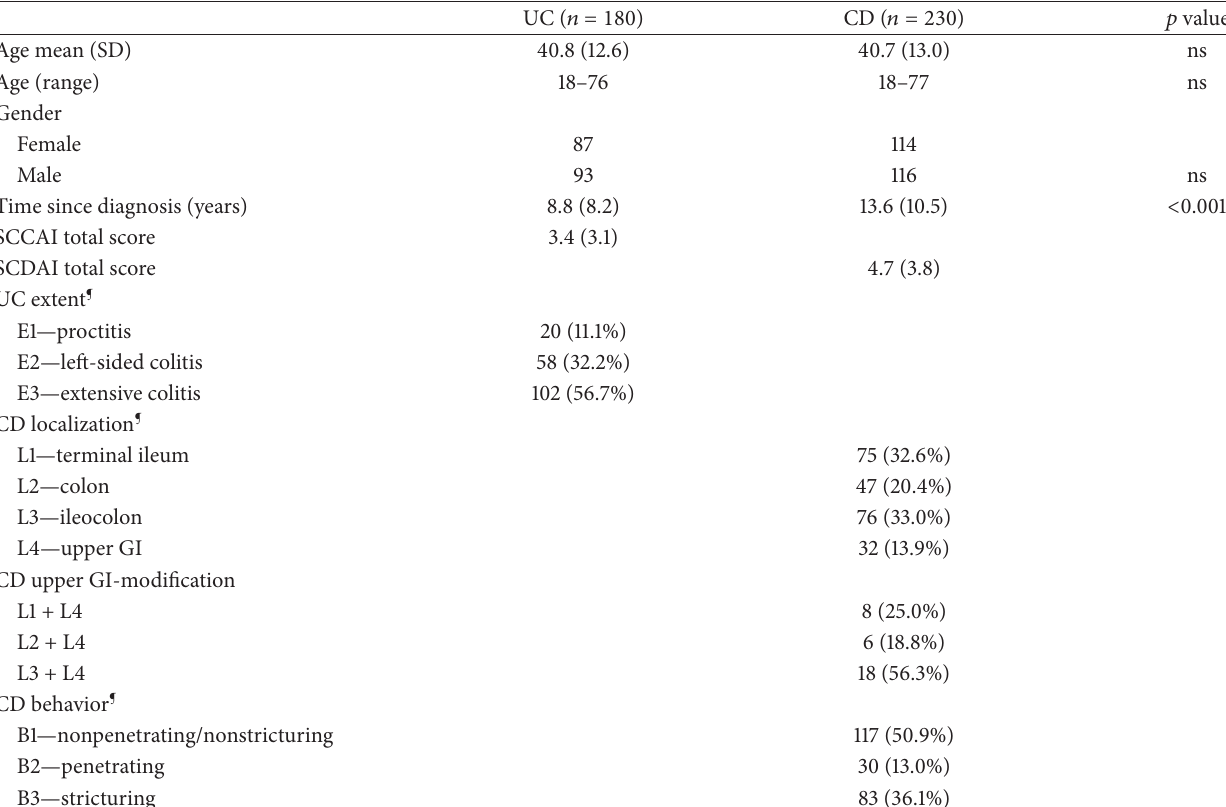
Table 1: Sociodemographic and clinical data according to diagnosis.